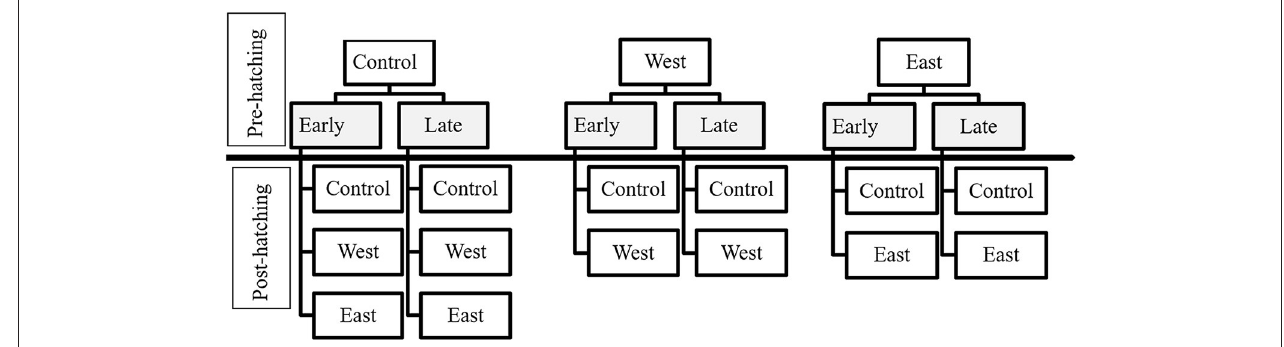
FIGURE 1 | Exposure treatments of egg masses and tadpoles according to the time of exposure and chytrid strain. Pre-hatching treatments are indicated in gray and above the separation line. Treatments for tadpoles (post-hatching) are listed below the separation